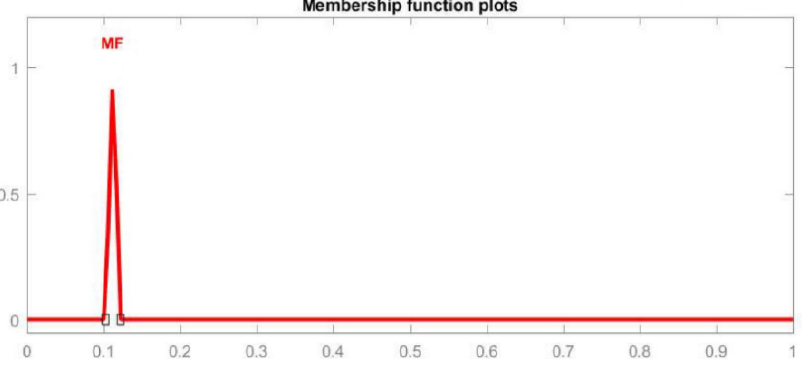
Figure 2. Membership function of R 2 ( α ) for linear